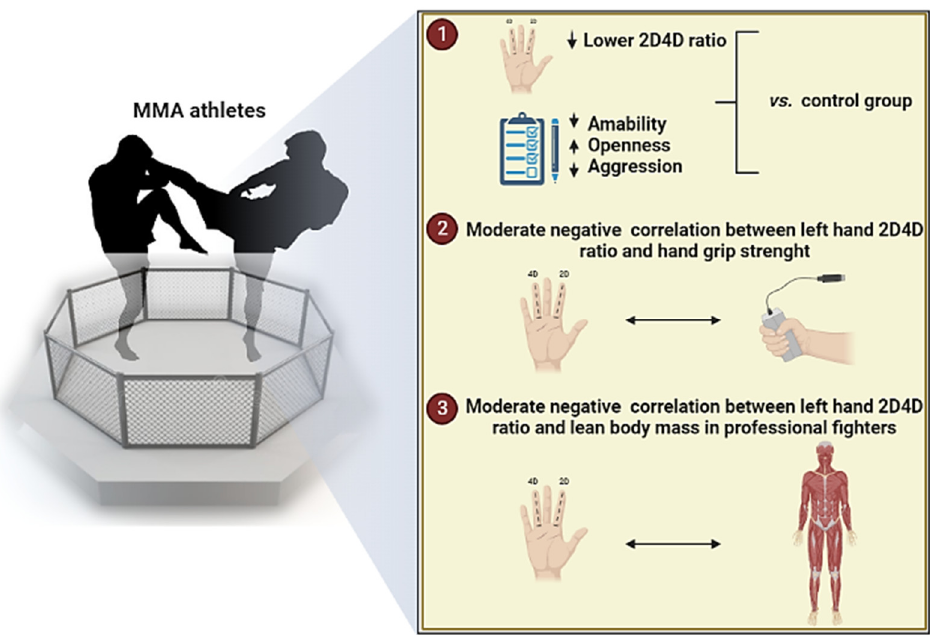
Figure 6. Overview of the main findings involved in MMA athletes.